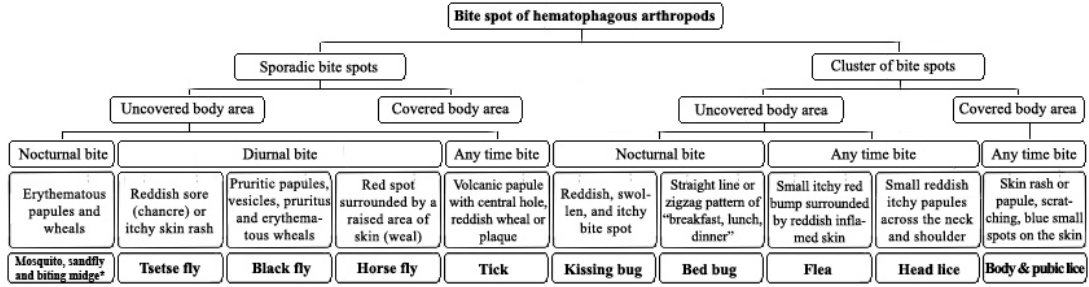
Figure 3. Clinical manifestations of arthropods bite spots. Due to similarities in clinical manifestation and blood feeding activity, the mosquitoes, sandflies and biting midges grouped together.